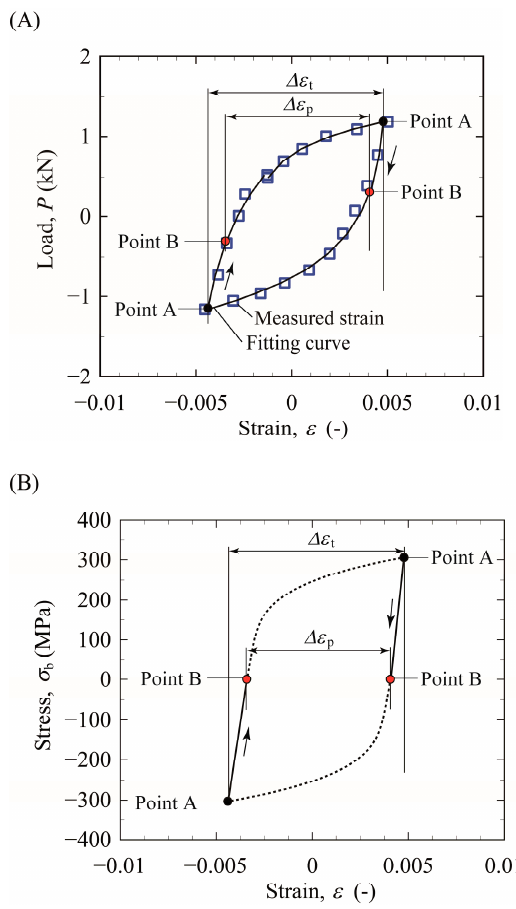
Figure A3. Technique to estimate the stress–strain curve at the specimen edge from the load–strain curve obtained by experiment under Δ ε t = 0.01 ( N/N f = 0.77): ( A ) load–strain curve obtained experi- mentally and ( B ) estimated stress–strain curve.